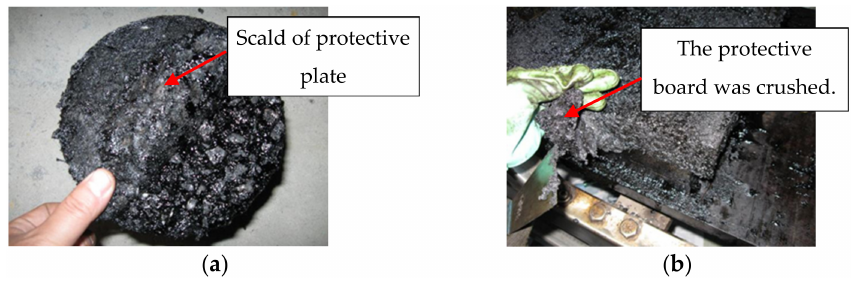
Figure 9. Burst resistance test phenomena of scheme II. ( a ) Scald of protective plate. ( b ) Protective board was crushed.